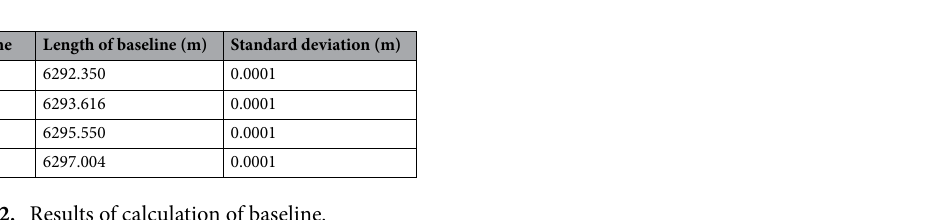
Table 2. Results of calculation of baseline.